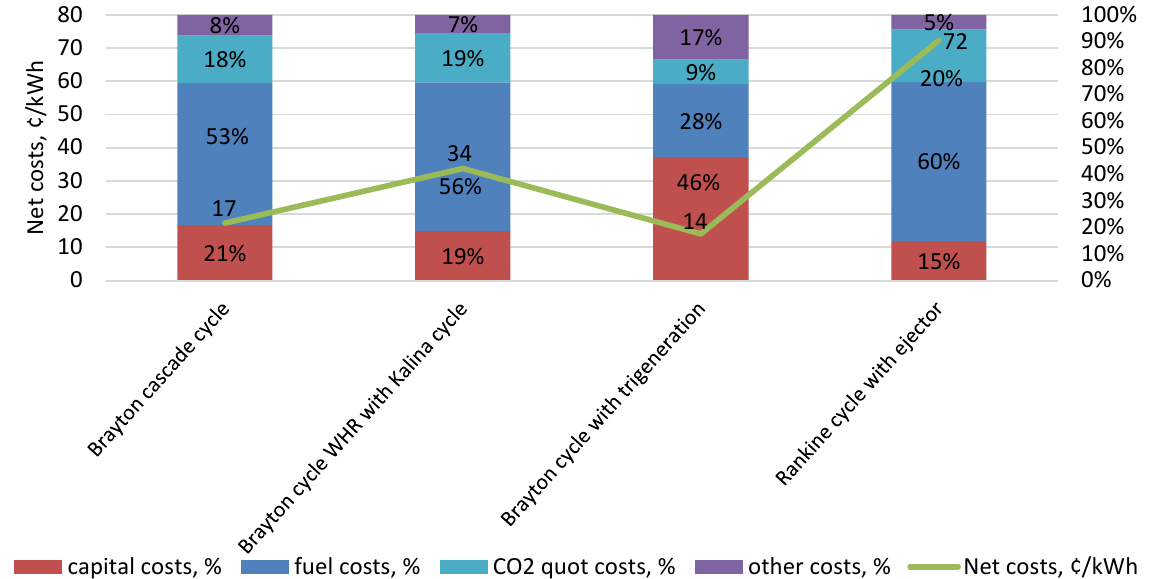
Figure 35. Cost of electric power generated with regeneration CO 2 power cycles at the cost of CO 2 emission quotas of 50 $/ton for microgeneration.